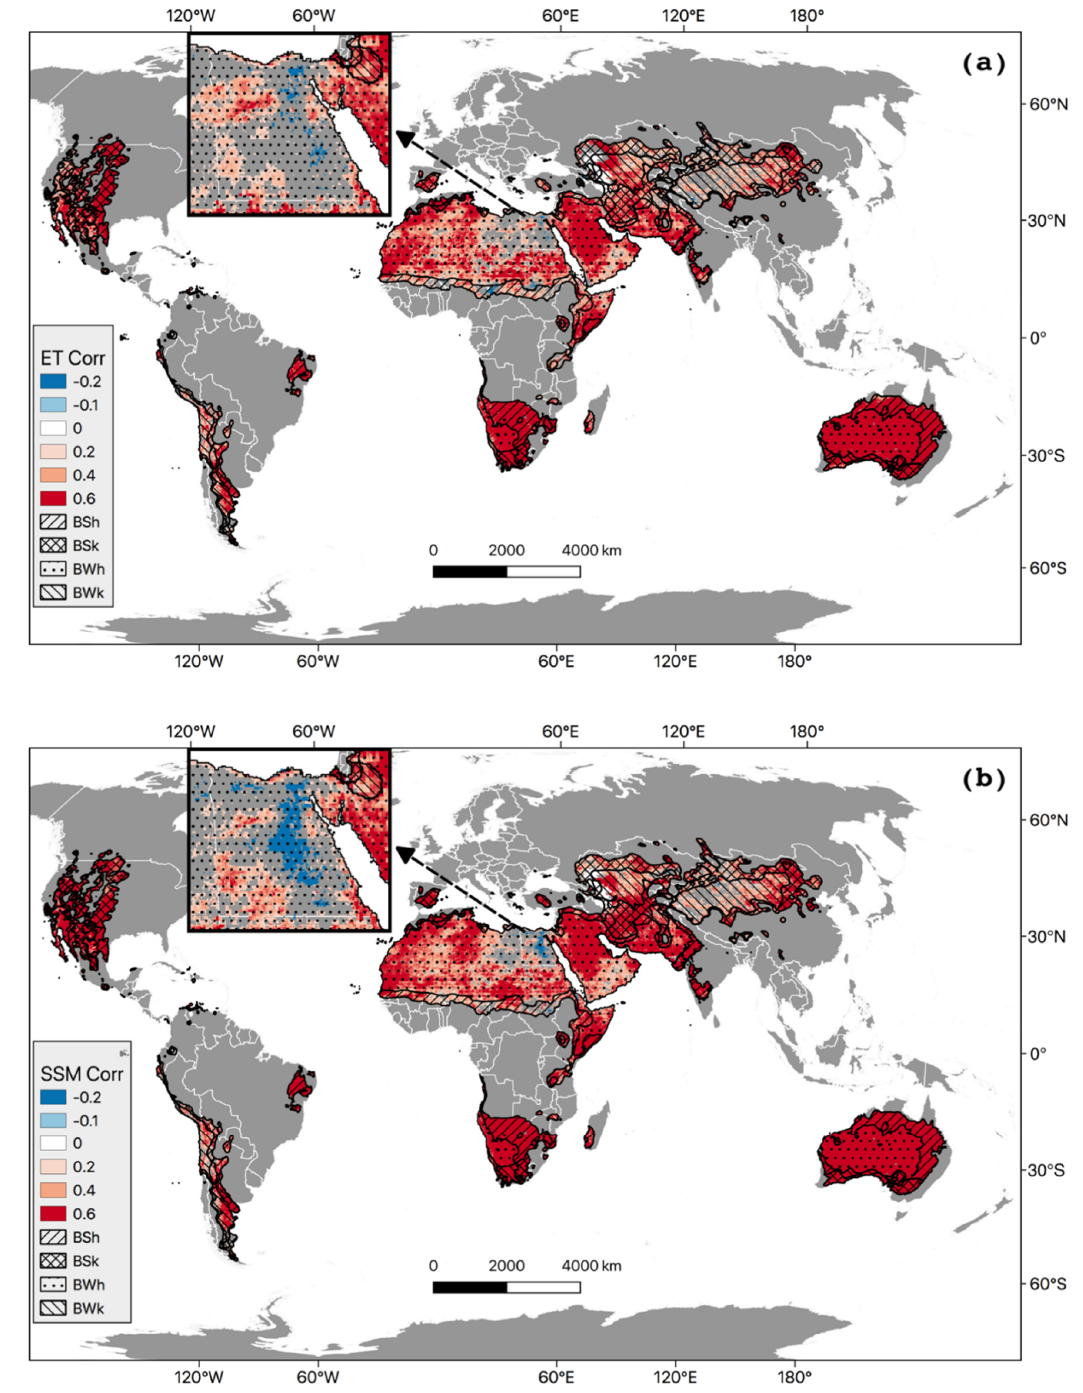
Figure 9. The correlation maps (correlation coefficient) between FLDAS and GLDAS in ( a ) ET and ( b ) SSM products calculated by monthly anomalies values during the years 2001–2019. Only regions with a confidence level of 95% are shown.